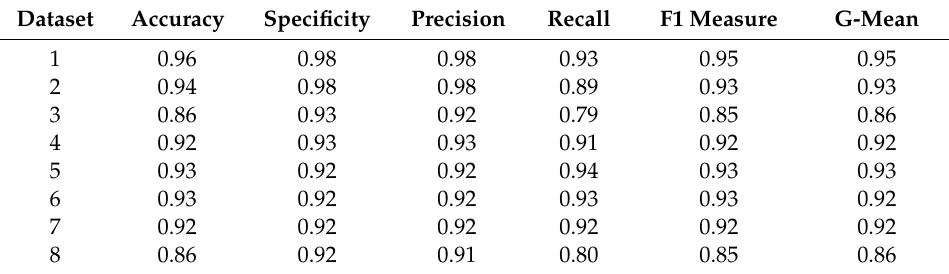
Table 4. Results for optimized Random Forests. Table 2. Results for optimized Random Forests.